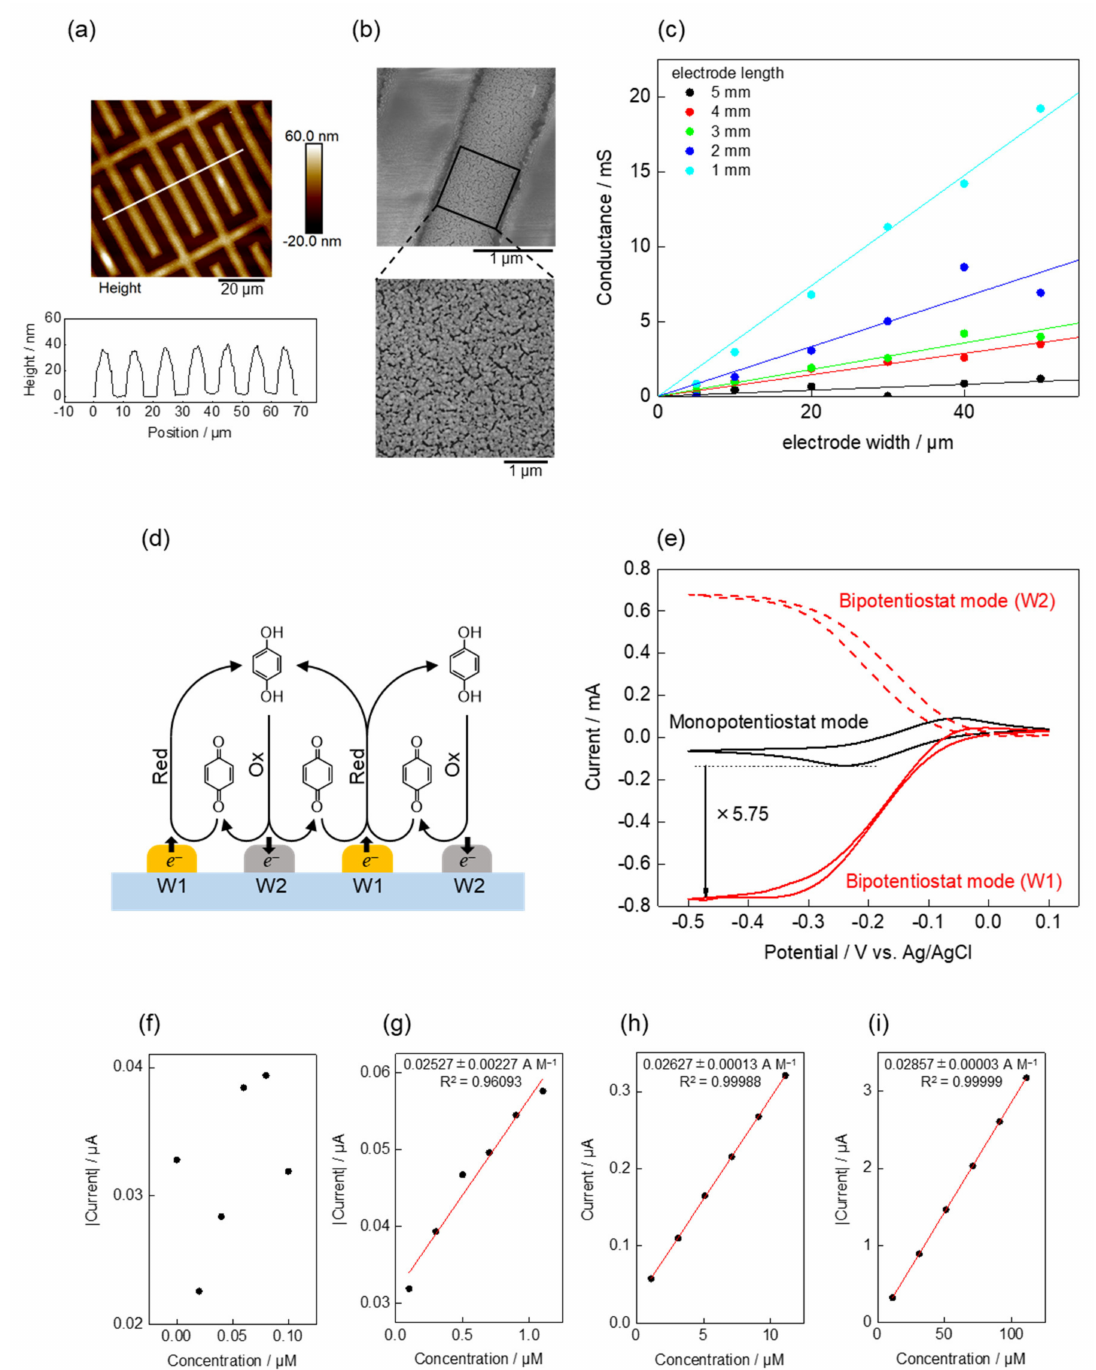
Figure 5. ( a ) Atomic force microscope (AFM) and ( b ) SEM images of interdigitated array electrodes with the extended edge design. ( c ) Electric conductance of interdigitated array electrodes plotted as a function of the electrode width. ( d ) Schematic of redox cycling by interdigitated array electrodes. ( e ) Cyclic voltammograms of 10 mM p -benzoquinone measured by the interdigitated array electrodes with line and space of 5 µ m/5 µ m. The black and red curves correspond to the results obtained by monopotentiostat mode and bipotentiostat mode, respectively. Current responses to ( f ) 0.01–0.1 µ M, ( g ) 0.1–1 µ M, ( h ) 1–10 µ M, and ( i ) 10–100 µ M p -benzoquinone measured by bipotentiostat